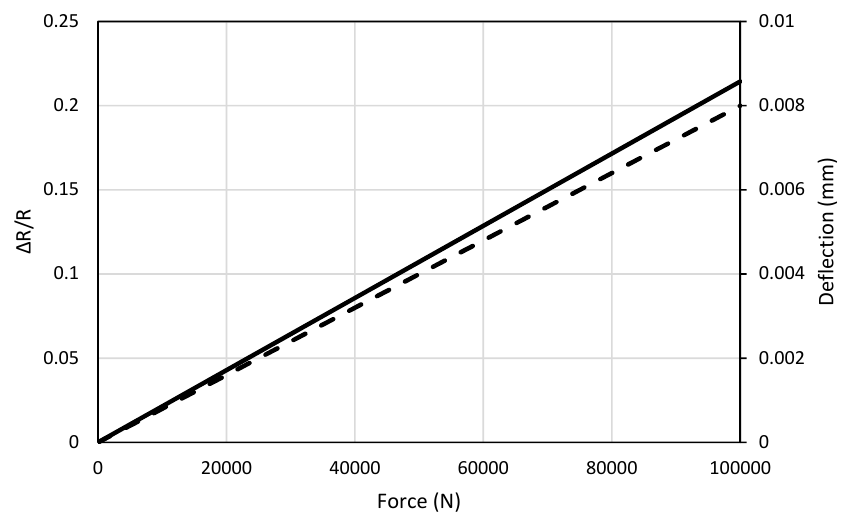
Figure 4. Stress–strain curve of fibers with different number of filaments: ( a ) 1 K, ( b ) 3 K, ( c ) 6 K and